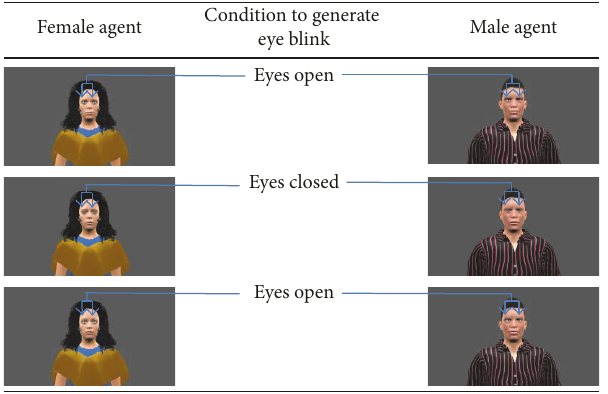
Figure 3: Example of typical frames used to generate eye blinks.